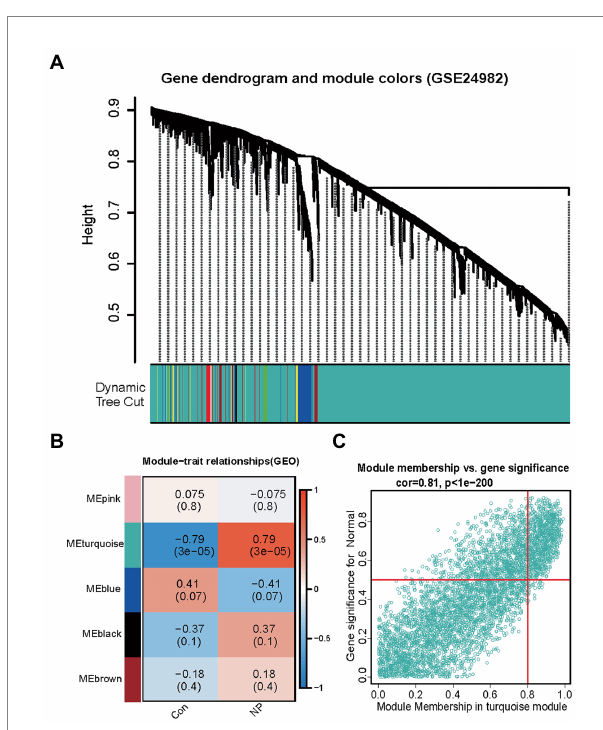
FIGURE 2 Identification of neuropathic pain-associated gene modules in the GEO dataset using WGCNA. (A) Dendrogram of all genes in the GSE24982 dataset was clustered on the basis of a topological overlap matrix (1-TOM). Each branch in the clustering tree represents a gene, while co-expression modules were constructed in different colors. (B) Module-trait heatmap of the correlation between the clustering gene module and neuropathic pain in the GSE24982 dataset. Each module contains the corresponding correlation coefficient and p value. (C) Scatter plot of module cyan has the strongest positive correlation with neuropathic pain in the GSE24982